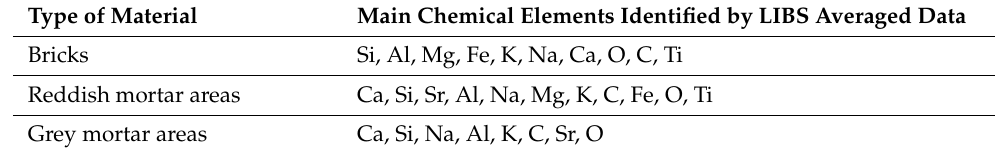
Table 1. Chemical elements identified using LIBS.